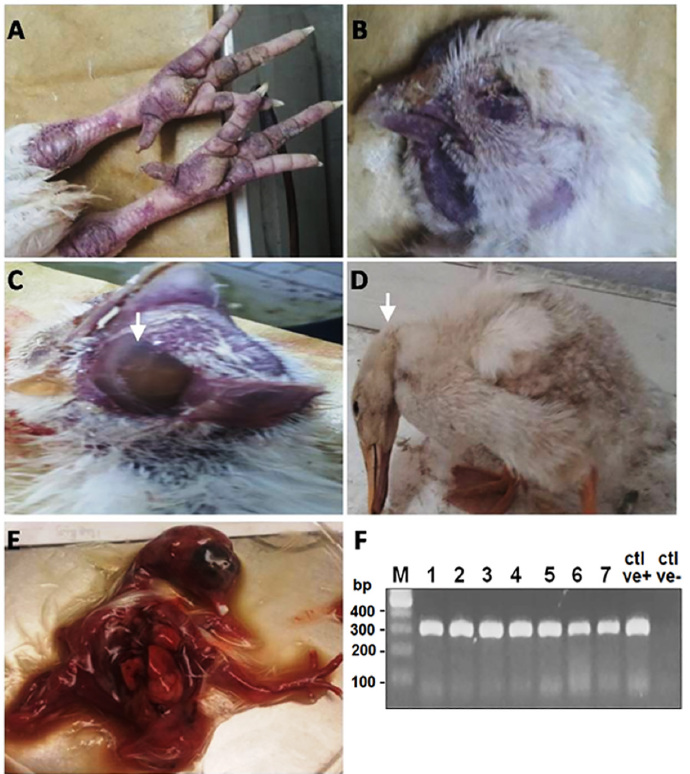
Fig 1. Naturally infected chickens and ducks by HPAIV H5N1. ( A ) Chickens: subcutaneous hemorrhages in non-feathered skin. (B ) Chickens: cyanosis of comb & wattles. ( C ) Chickens: facial edema. ( D ) Ducks: nervous signs, torticollis. ( E ) Infected chicken embryos: chicken embryos were inoculated with supernatants of homogenized testicular tissue of naturally infected layer chickens; the inoculated embryos died within 48hrs with severe congestion and hemorrhages after the first passage. ( F ) PCR amplification for HA gene showing bands of 317bp in size. First lane: Molecular marker of 100 bp, Lane 1 – 7: Positive samples, Ctrl +ve: Positive AIV subtype H5N1, Ctrl-ve: Negative